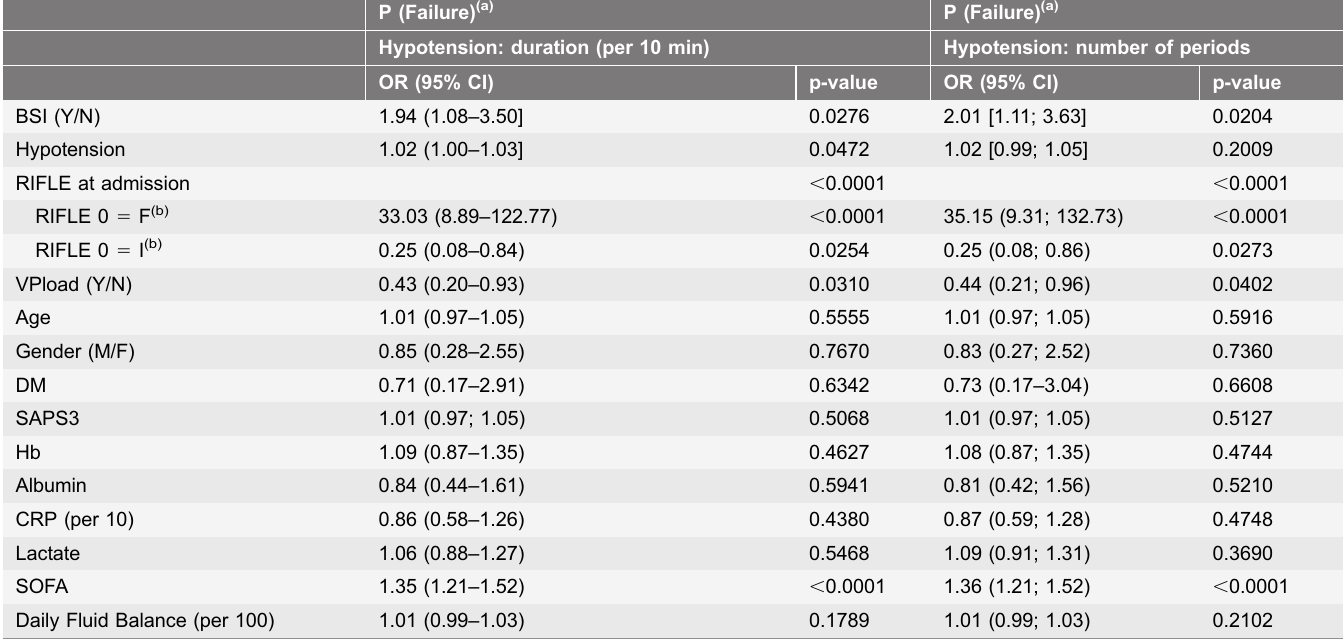
Table 4. Influence of sepsis and hypotension on the evolution of the RIFLE criteria.